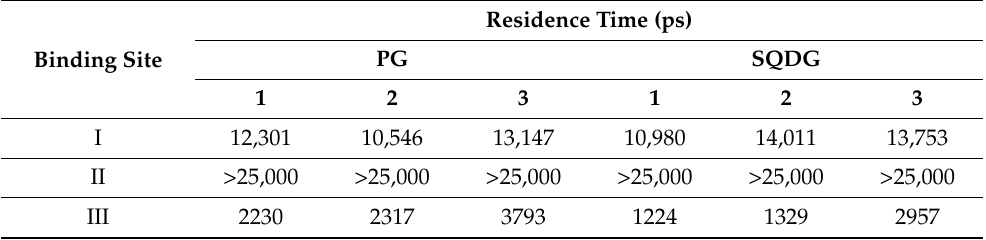
Table 1. Behavior of the two LPOR regulators at each binding site during the MD